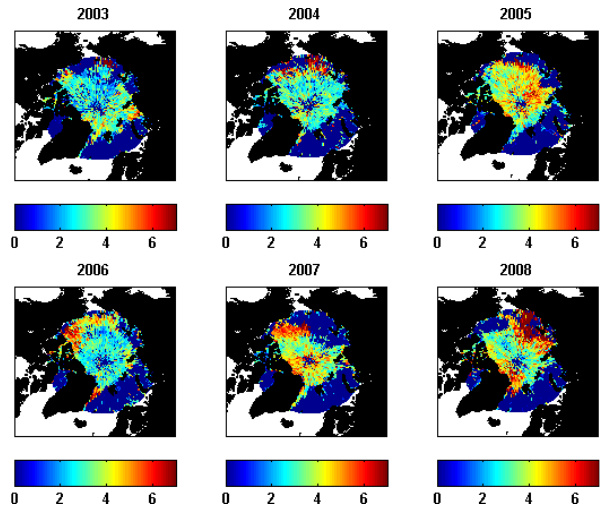
Fig. 7. Inter-annual variations in the inversion strength (in K) for the month of June. Notice that the year 2007 stands out clearly.